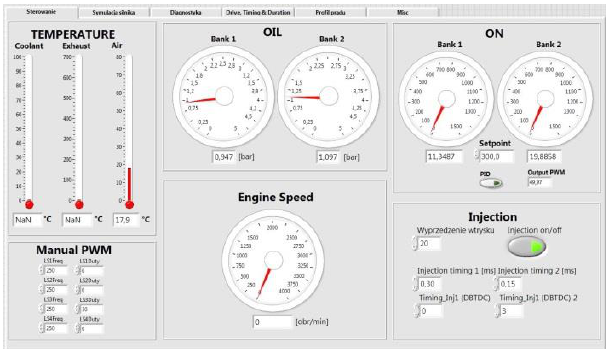
Fig. 3. The engine control panel